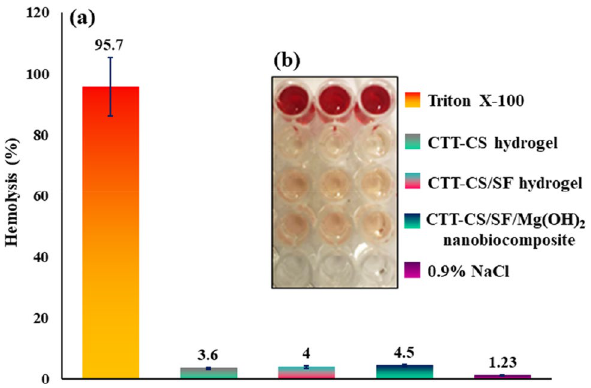
Figure 8. ( a , b ) Hemolysis histogram and 96-well plate image of Triton X-100 (positive control), CTT-CS hydrogel, CTT-CS/SF hydrogel,